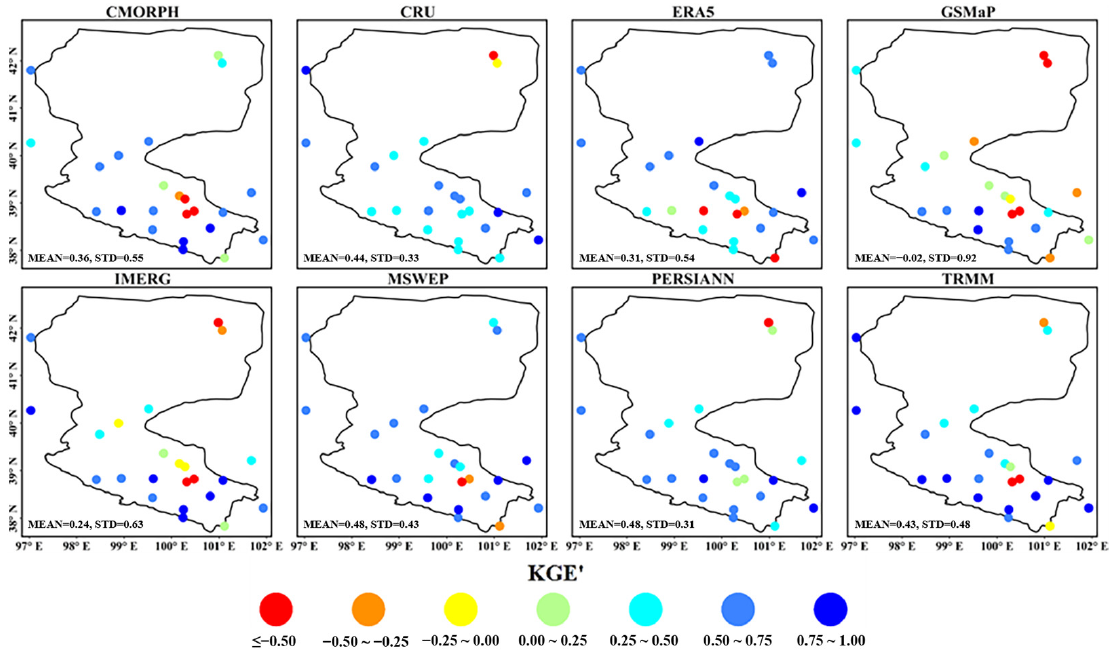
Figure 12. Spatial distributions of KGE’ of monthly precipitation estimates from each product for stations over the HRB during 2016–2019.